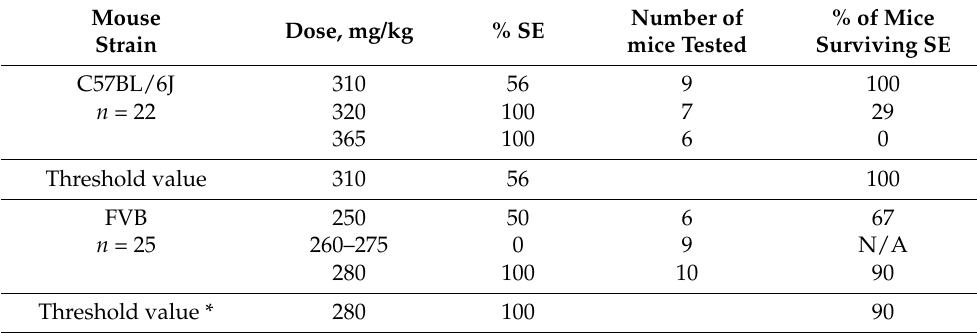
Table 4. Differences in sensitivity to pilocarpine in 3 weeks old C57BL/6J and FVB